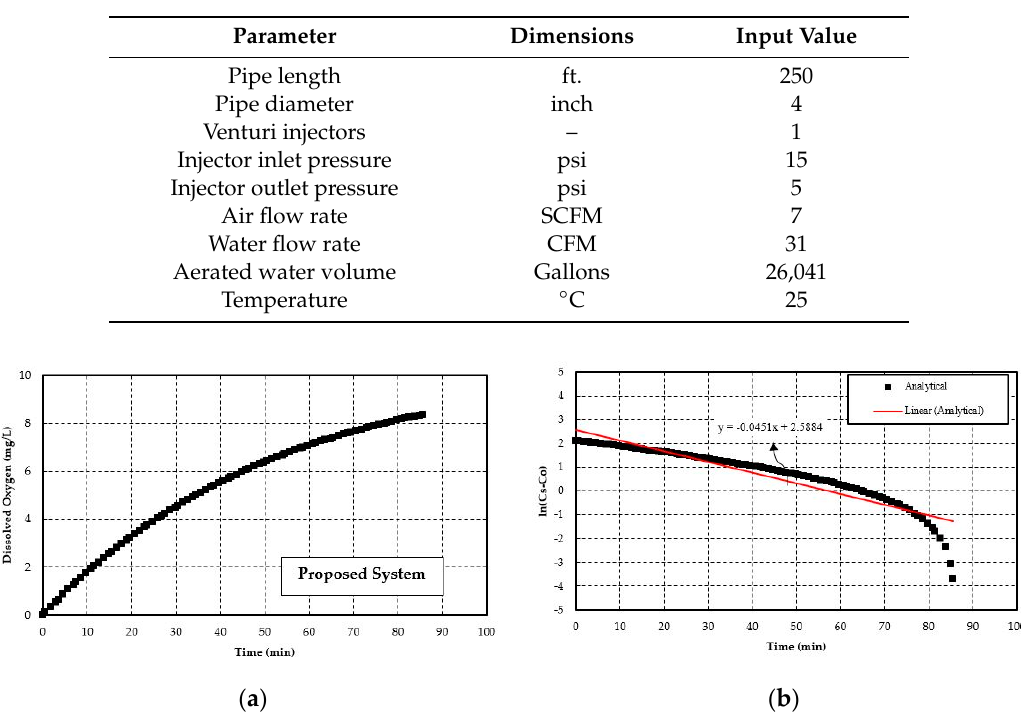
Figure 11. Proposed System: ( a ) Dissolved (mg/L) oxygen vs. time (min); ( b ) Determination of oxygen transfer coefficient.